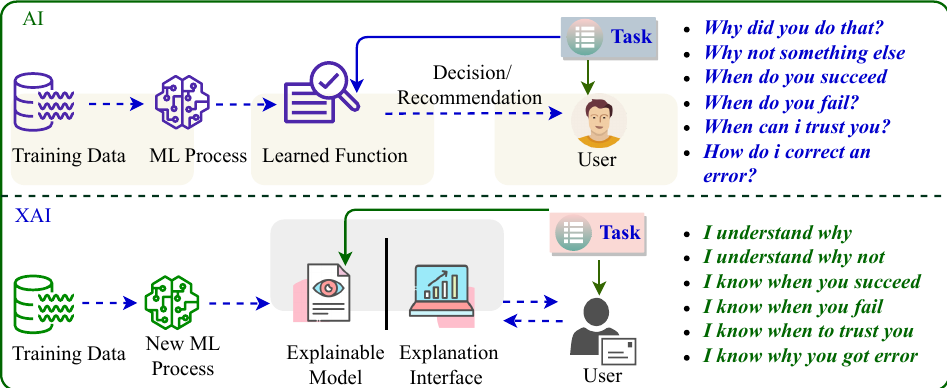
Figure 2. Difference between the working methodology of AI and